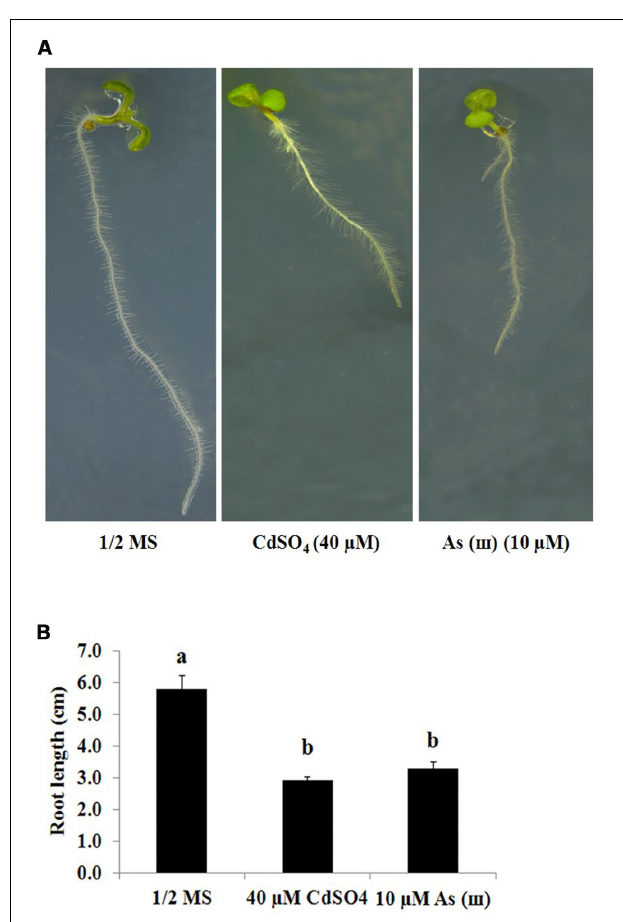
FIGURE 1 | Inhibitory effect of Cd (CdSO 4 ) and As(III) (AsNaO 2 ) stress on primary root growth in Arabidopsis . (A) Morphology of 1-week-old seedlings germinated and grown on 1/2 MS agar plates containing no metal (left), 40 µ M CdSO 4 (center), and 10 µ M AsNaO 2 (right). (B) Quantification of the primary root length of Arabidopsis shown in (A) . Values are average ( ± SE) of three independent experiments, each involving 10 seedlings. Different letters in each column indicate a significant difference according to Tukey’s multiple comparison test ( p ≤ 0.01).